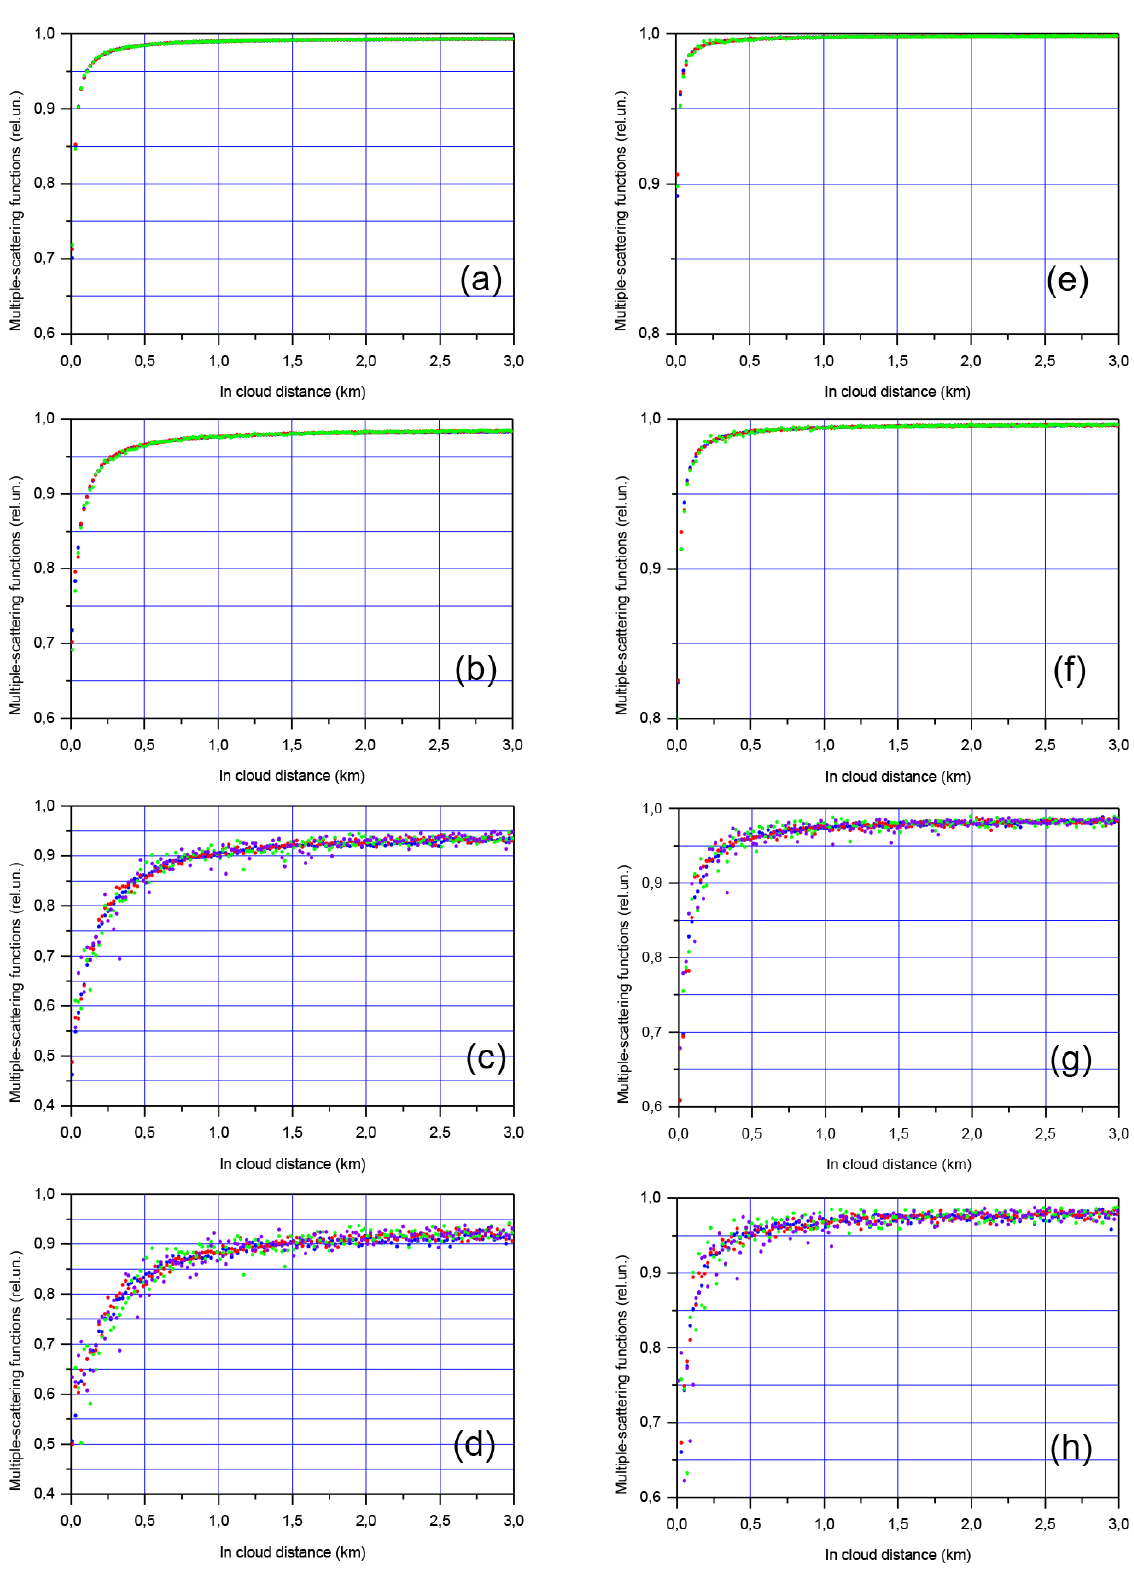
Figure 6. MC simulations of multiple-scattering functions η MS (d) . The full RFOV is 1.0mrad (a–d) and 0.25mrad (e–h) . Coarse aerosol (a, e) , water cloud (b, f) , JS cirrus (c, g) , Ci cirrus (d, h) . The extinction coefficient is 1.0km − 1 (blue points), 0.5km − 1 (red points), 0.2km − 1 (green points), and 0.06km − 1 (purple points). The distance to the cloud base is 1km.